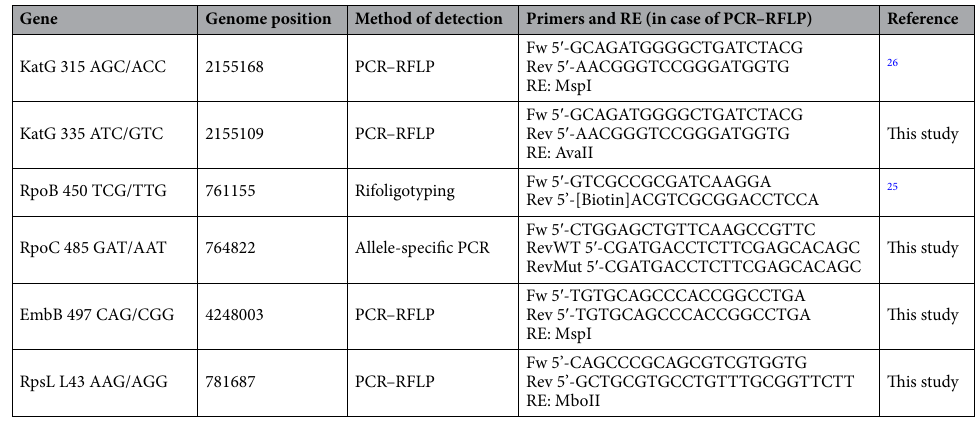
Table 2. Molecular assays used for detection of six drug resistance/compensatory mutations specific of the Beijing 1071-32-cluster. RE, restriction